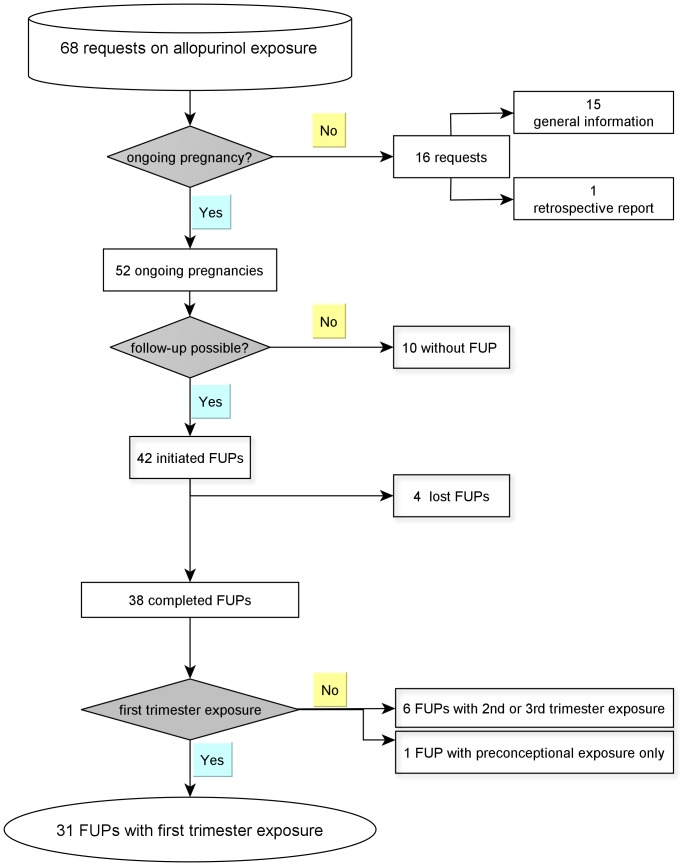
Flow chart on cases of allopurinol exposure and pregnancy (FUP =  Follow-up).